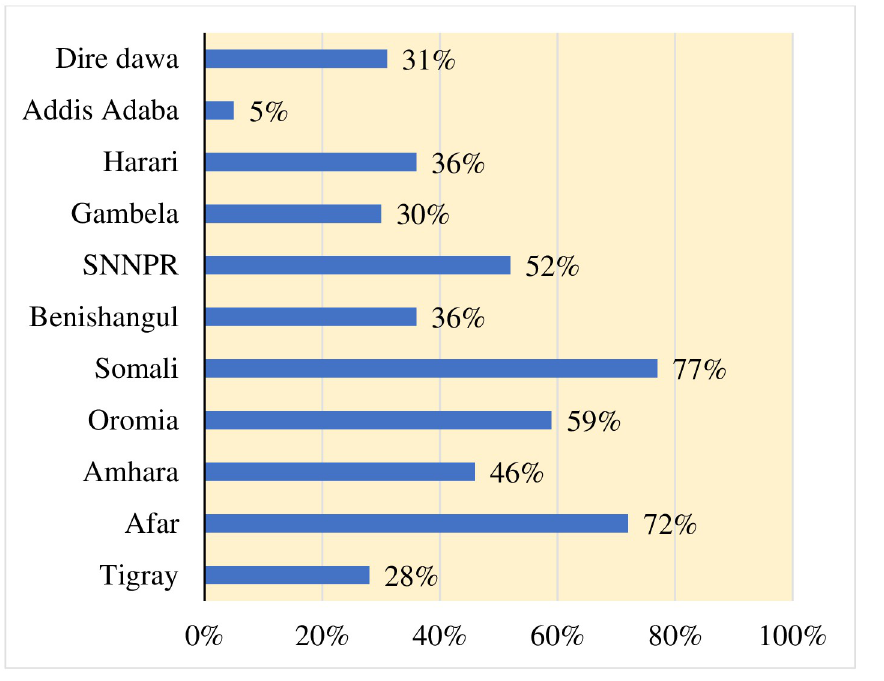
Fig 1. Regional prevalence of home delivery in Ethiopia in